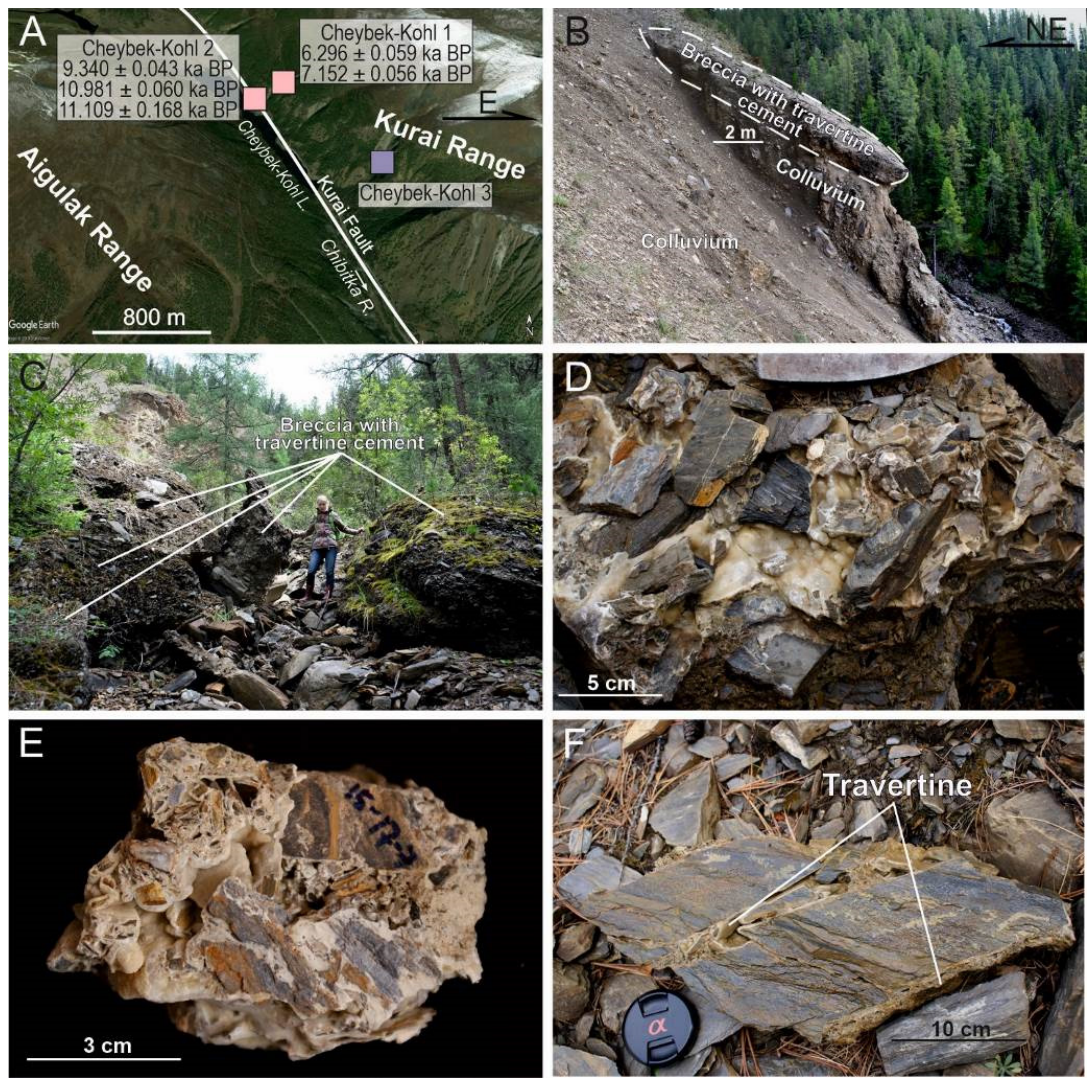
Figure 3. Location and morphology of the Cheybek-Kohl 1 and Cheybek-Kohl 2 travertines. ( A ) Active faults, location, and U-Th dates of the Cheybek-Kohl 1 (50.400556° N, 87.611389° E) and Cheybek-Kohl 2 (50.40144° N, 87.60491° E) travertines. ( B ) Remnant of the breccia with travertine cement capping the colluvium. ( C ) Boulders of breccia with travertine cement truncated by a creek. ( D,E ) White-yellow sparry and micritic calcite cementing Lower Devonian shale clasts; druse calcite aggregates are present in voids and small cavities. ( F ) Tensional fissures, lined with travertine carbonate and hosting shale clasts.